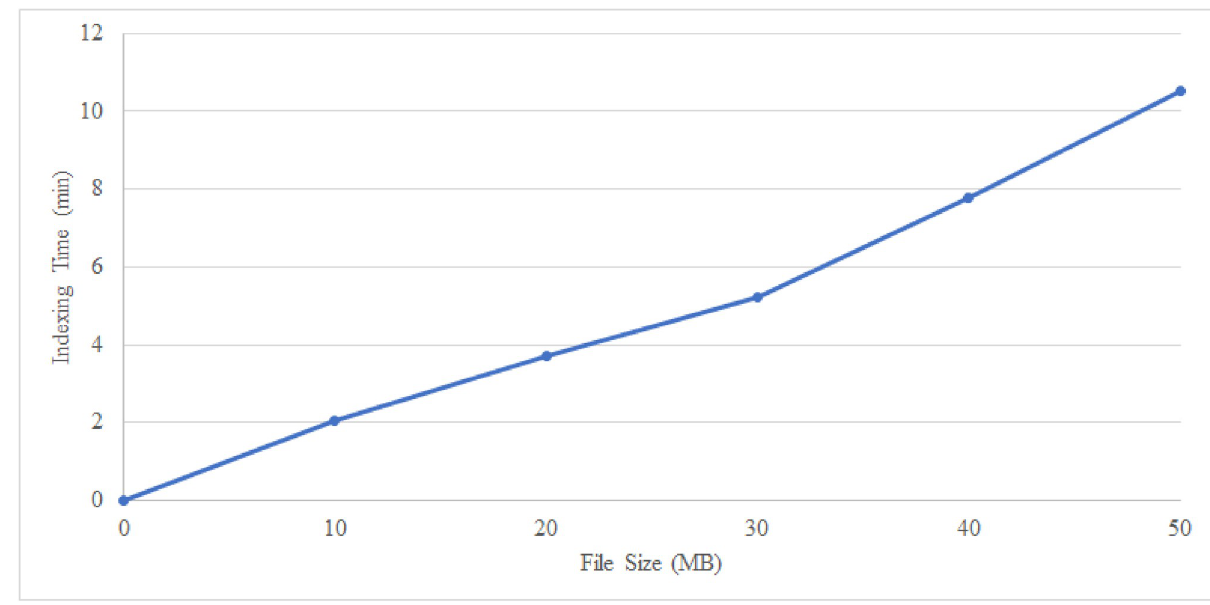
Fig 7. EHR indexing time based on different file